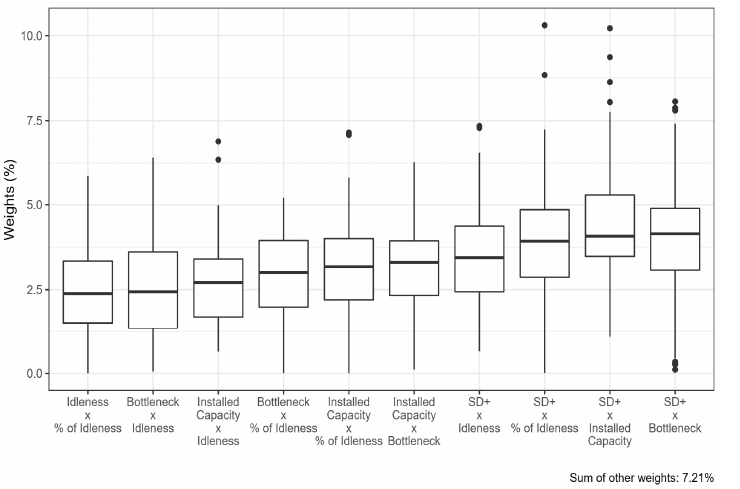
Figure 8. Endogeneity weights for pairs of models (1)–(12): major combinations.